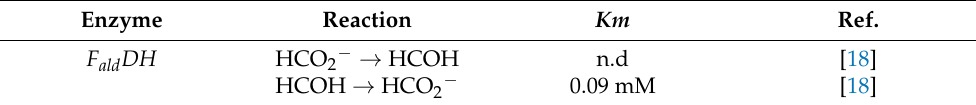
Table 2. Km values for the formate reduction–formaldehyde oxidation reactions. Enzyme Reaction Km Ref. F ald DH HCO 2 − → HCOH n.d [18] HCOH → HCO 2 − 0.09 mM